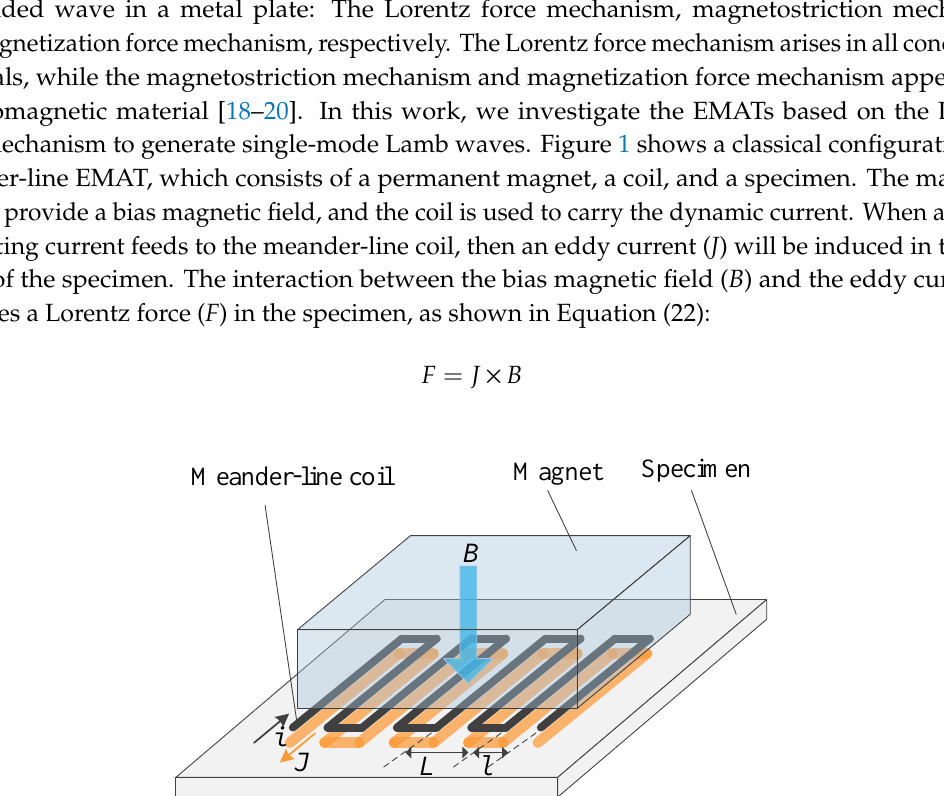
Figure 2. Phase velocity dispersion curves for A0, A1, S0, and S1 Lamb wave modes in aluminum plates.